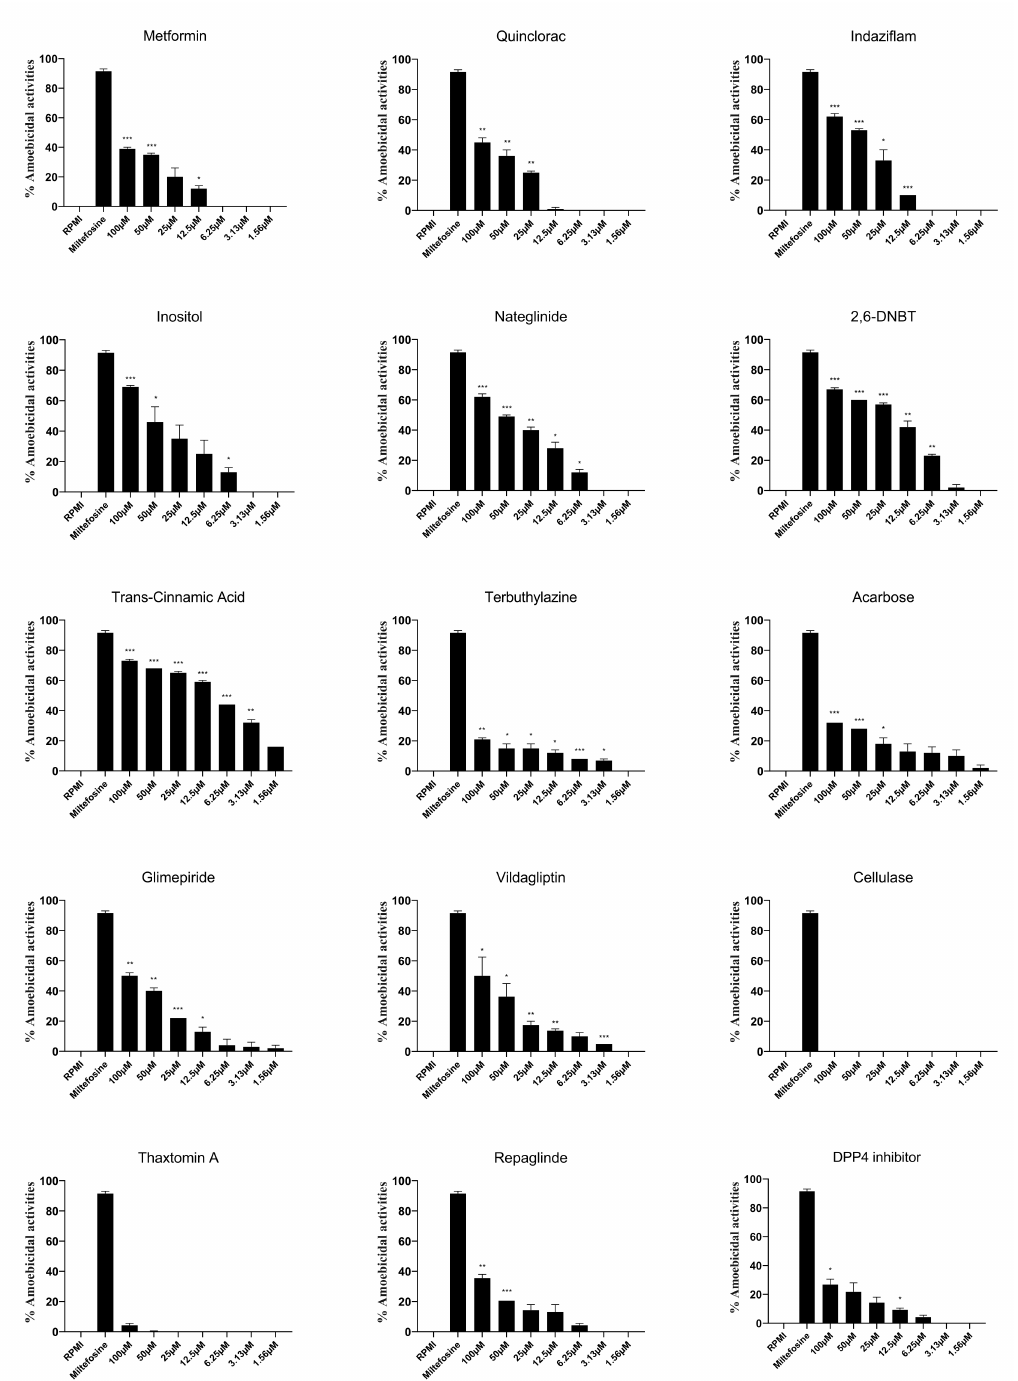
Figure 1. The amoebicidal activities of compounds against N. fowleri trophozoites. N. fowleri tropho- zoites were incubated with various concentrations of compounds for 24 h and trophozoites viability was determined using Trypan blue. Percentage amoebicidal activity was calculated by: [((RPMI cell count − cell count for sample)/RPMI cell count) × 100)]. The activities of solvents alone were negated from the activities of the compounds. The data is presented as the mean ± standard error (*: p < 0.05, **: p < 0.01, ***: p < 0.001 using student t -test; two tailed